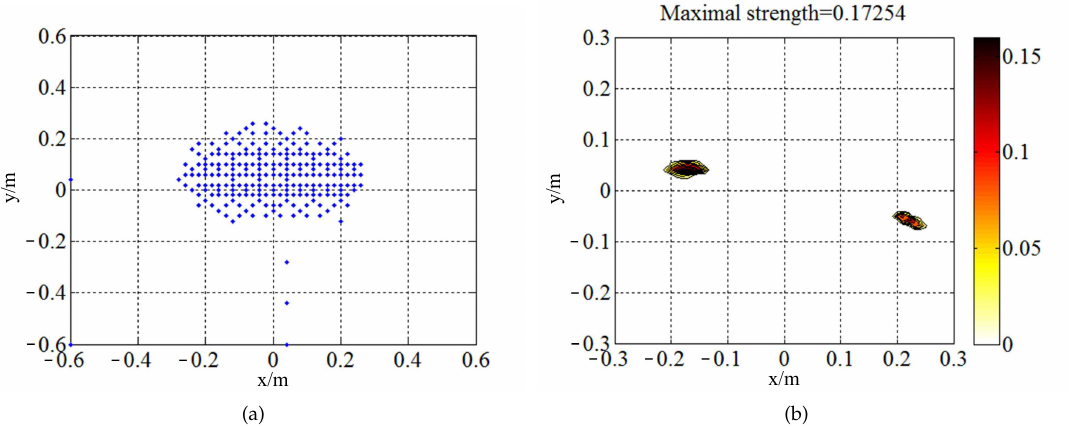
Figure 9. The results of adding computational grid refining at 500 Hz by wavelets method (with unit of m 4 /s 2 ). ( a ) the essential points of extracted (blue dots); ( b ) the sources reconstructed in the essential